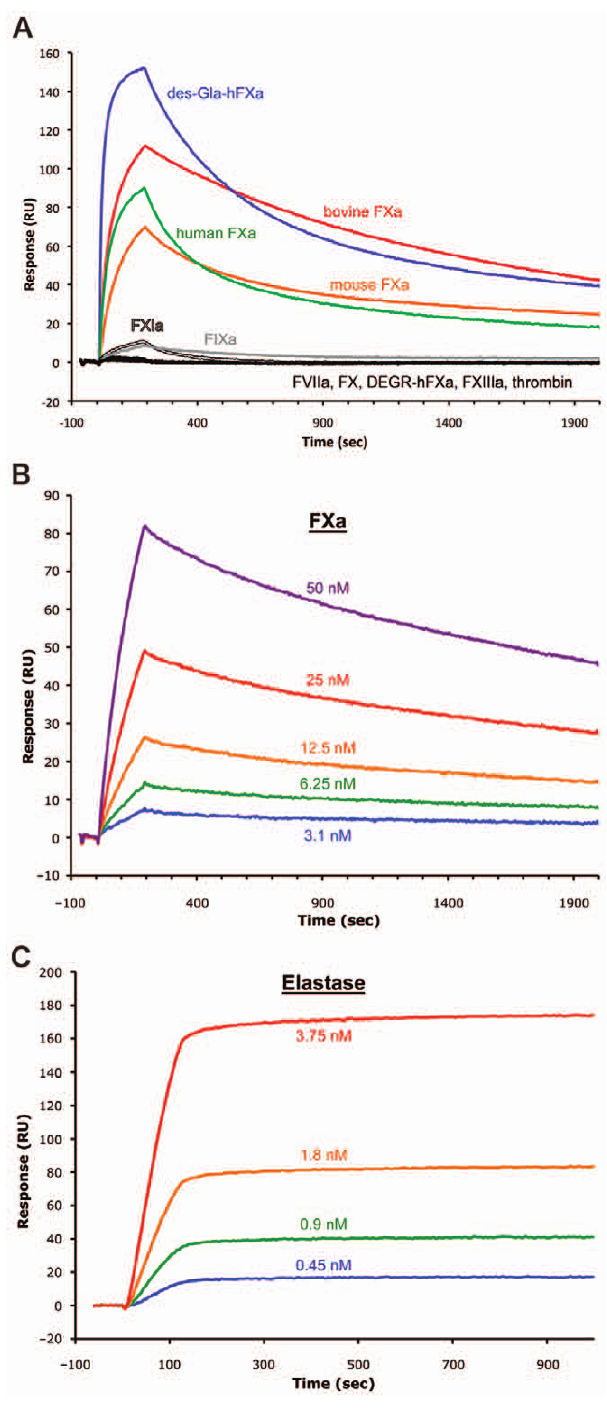
Figure 6. rSimukunin displays high-affinity binding to FXa and elastase. (A) Surface Plasmon Resonance (SPR) Sensorgrams show mouse, bovine, and human FXa, the FXa derivatives des-GLA-hFXa and DEGR-hFXa, and other coagulation factors (all tested at 200 nM) binding to immobilized rSimukunin. (B) Sensorgrams for various concentrations of human FXa (in nM: purple, 50; red, 25; orange, 12.5; green, 6.25, blue, 3.1) binding to immobilized rSumukunin. (C) Sensorgrams for various concentrations of elastase (in nM: red, 3.75; orange, 1.8; green, 0.9; blue, 0.45) binding to immobilized rSimukunin. Data were fitted using a 1:1 binding model (Langmuir). RU: resonance units.